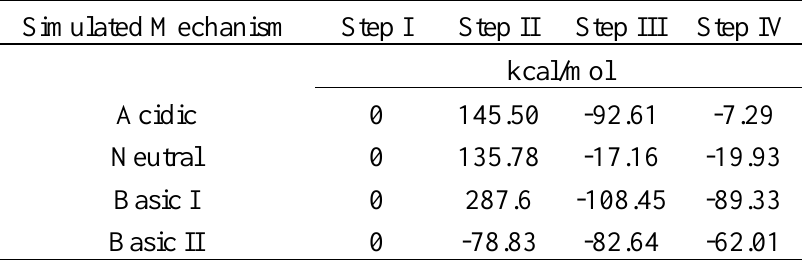
Table 3. Comparison of possible reaction